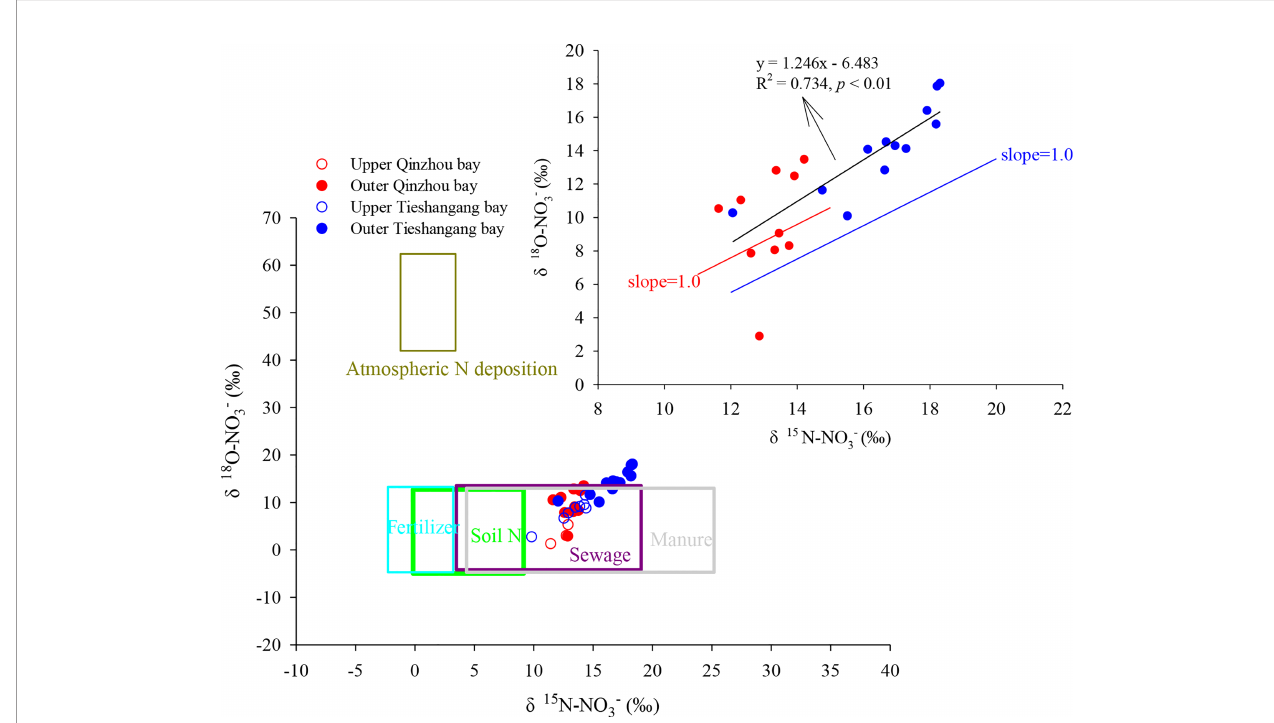
FIGURE 7 | Values of d 15 N − NO − 3 and d 18 O − NO − 3 in Qinzhou Bay (red dots and circles) and Tieshangang Bay (blue dots and circles) and in various source reservoirs (boxes). In the larger graph, the isotopic composition of fi ve potential nitrate sources are adapted from Chen et al. (2019), (Kendall 1998), Xue et al. (2009) and Zhang et al. (2018). The inset in the upper right corner is the plots of d 15 N − NO − 3 and d 18 O − NO − 3 in outer Qinzhou Bay (red dots) and outer Tieshangang Bay (blue dots). Assimilative uptake would cause nitrate dual isotopes to increase along a slope of